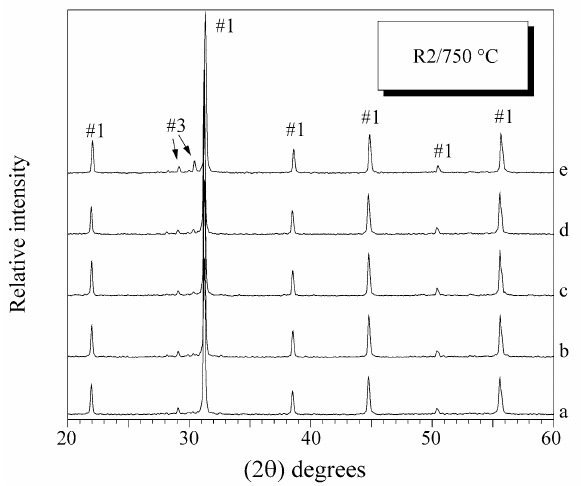
Figure 7. Evolution of perovskite phase amounts for PMN